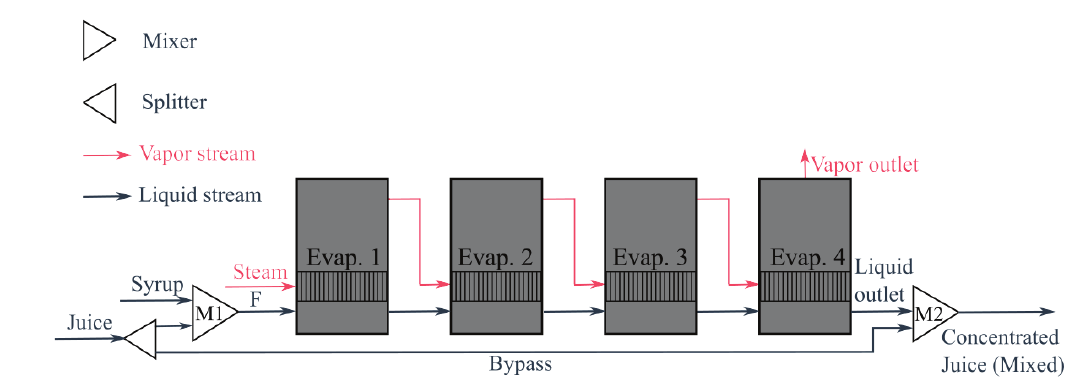
Fig. 1 – Schematic representation of the evaporation